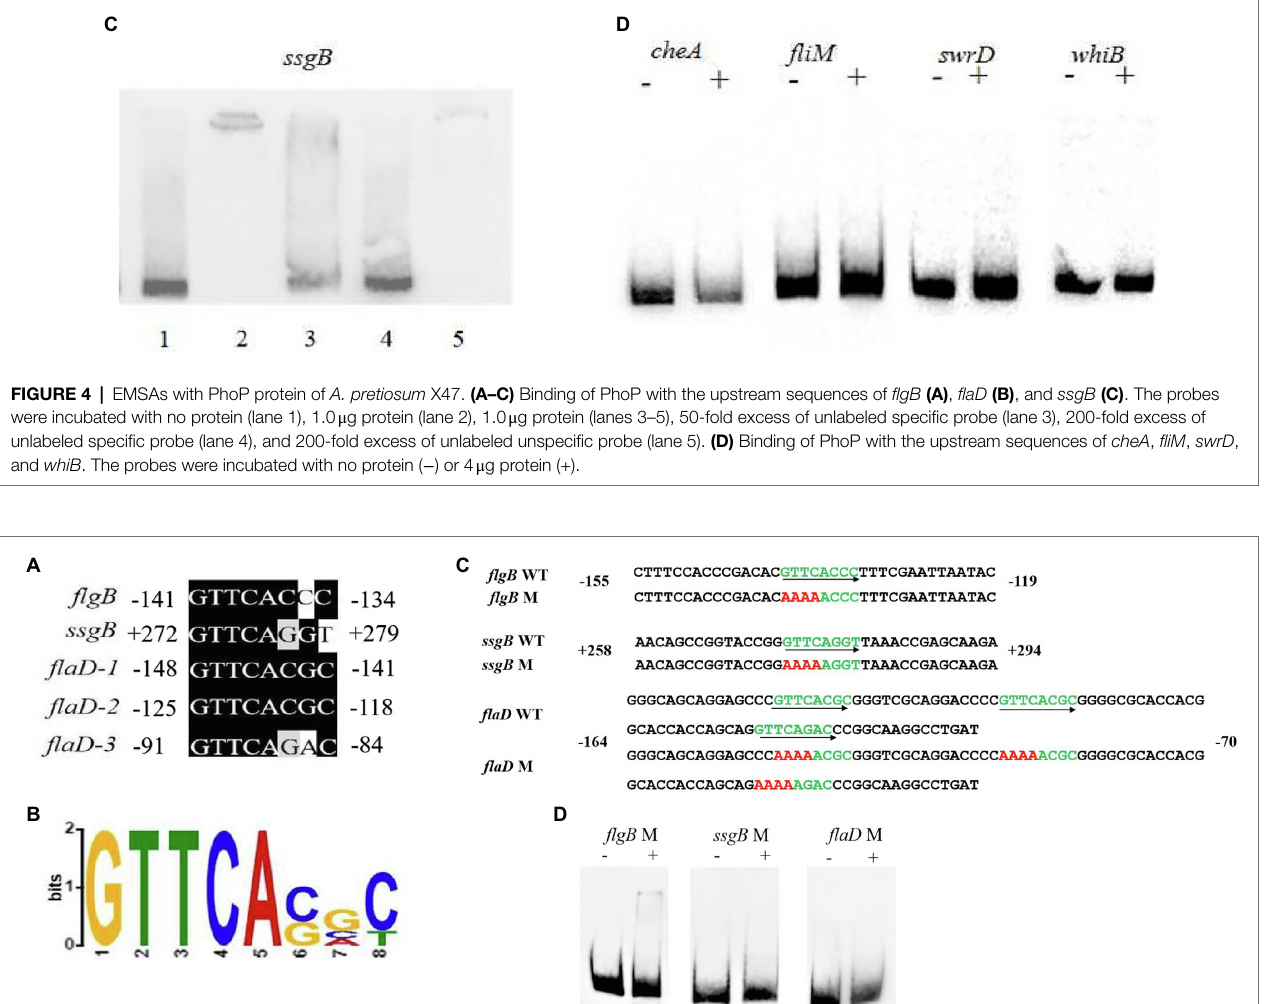
and chemotaxis-related genes was upregulated in the phoP deletion mutant ( Table 1 ). Interestingly, whereas PhoP regulates positively these groups of genes in X. citri subsp. citri